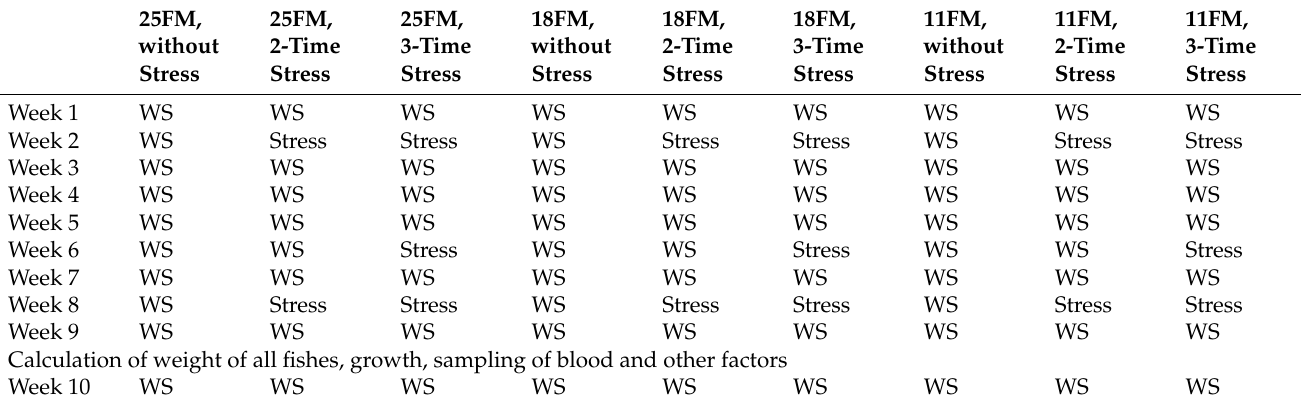
Table 2. The treatments of the present study under fish meal replacement, scheduled early mild stress and AC stress at the end of